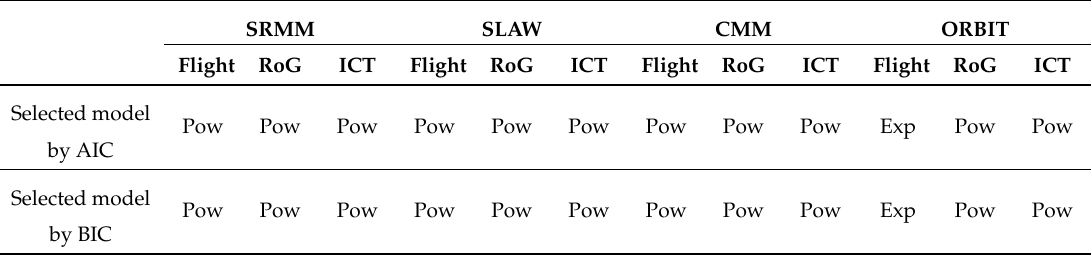
Figure 10. ( a ) Flight distributions of various models with the real road map. ( b ) The radius of gyration distributions of various models with the real road map. ( c ) ICT distributions of various models with the real road map. Table 5. Results from AIC and BIC between a truncated power-law distribution (denoted as Pow) and an exponential distribution (denoted as Exp) over flights, the radius of gyration (denoted RoG), and ICTs of various synthetic models with the real road map of Helsinki